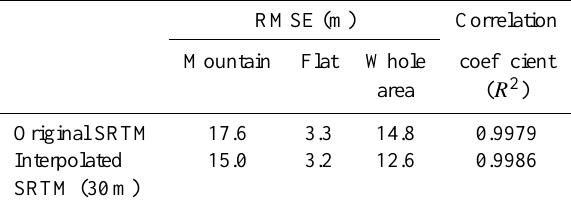
Table 3. SRTM before and after interpolation to 30m.